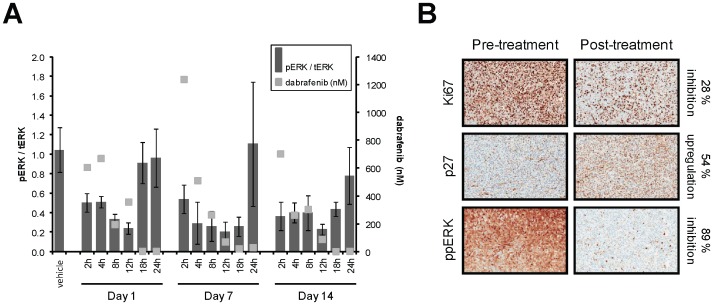
Modulation of pharmacodynamic markers by dabrafenib in BRAFV600E tumors.Mice bearing A375P tumor xenografts were treated orally with 30 mg/kg dabrafenib, once daily for 14 days. Blood and tumors from vehicle- and dabrafenib-treated animals were analyzed for compound concentration and pERK inhibition, respectively (A). Phospho-ERK (pERK) is normalized to total ERK (tERK). Tumors harvested 6h post-last 6th dose were stained for Ki67, p27, and ppERK by immunohistochemistry and compared with pre-treatment controls (B). Data are representative of n = 3 studies and percent changes were calculated from the ratio of positively stained cells following drug treatment to those following vehicle control treatment, each as a percentage of the total cell population.